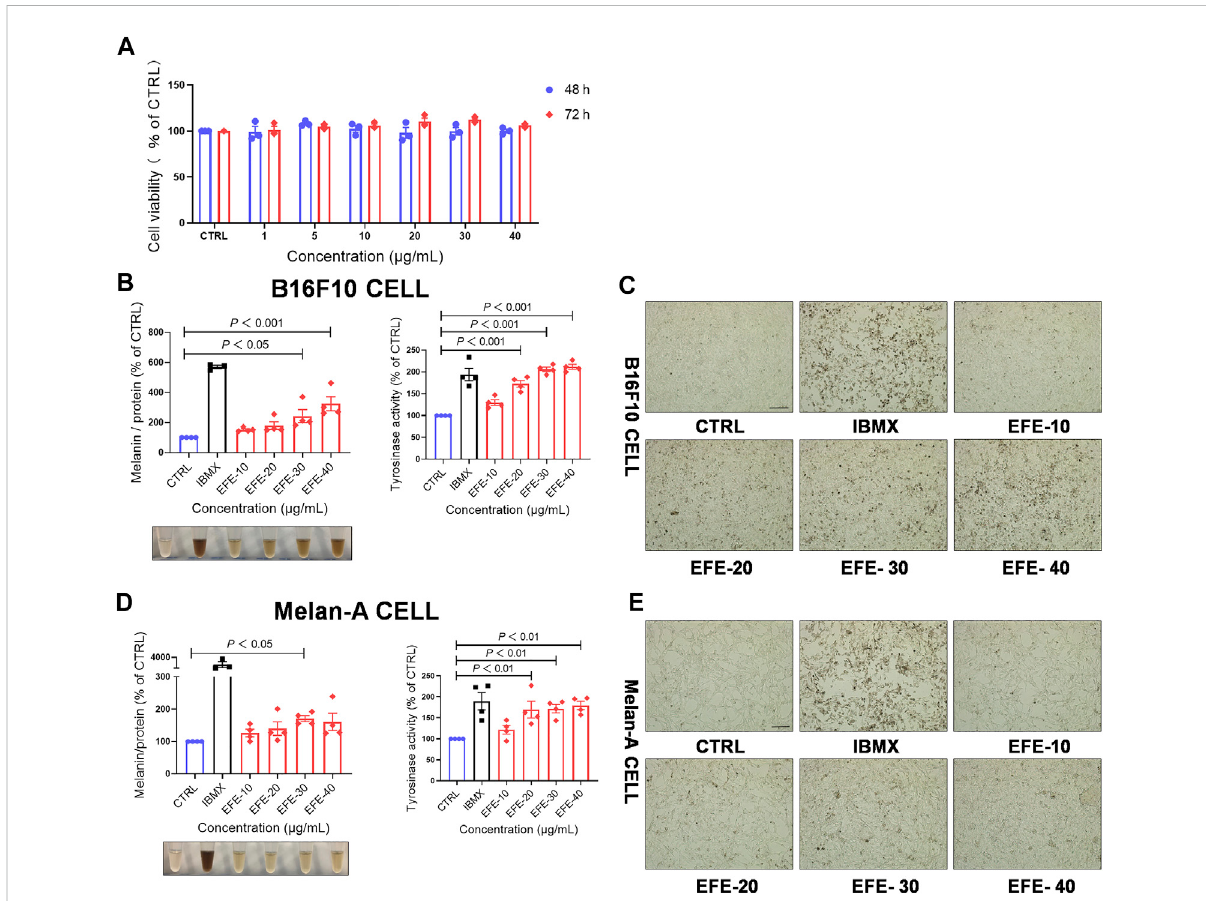
FIGURE 1 EFE increases melanin production and promotes tyrosinase activity in a concentration- and time-dependent manner. (A) CCK-8 cells viability assay (different concentration of 1 μ g/ml, 5 μ g/ml, 10 μ g/ml, 20 μ g/ml, 30 μ g/ml, and 40 μ g/ml for 48 h and 72 h in B16F10 cells); (B) melanin content, melanin color,and tyrosinaseactivityon B16F10cells based ondifferentconcentrationsof10 μ g/ml, 20 μ g/ml, 30 μ g/ml, and40 μ g/mlfor 72 h, IBMX (100 μ M); (C) representative images of intracellular melanin granules on B16F10 cells (scale bar = 100 μ m); (D) melanin content, melanin color, and tyrosinase activity on Melan-A cells based on different concentration of 10 μ g/ml, 20 μ g/ml, 30 μ g/ml, and 40 μ g/ml for 72 h, IBMX (100 μ M); and (E) representative images of intracellular melanin granules on Melan-A cells (scale bar = 100 μ m). For graphical representation, data are presented as mean ± SEM ( n ≥ 3 in each group), p < 0.05, p < 0.01, and p < 0.001 vs. CTRL are considered signi fi cant. Representative image from three independent experiments is